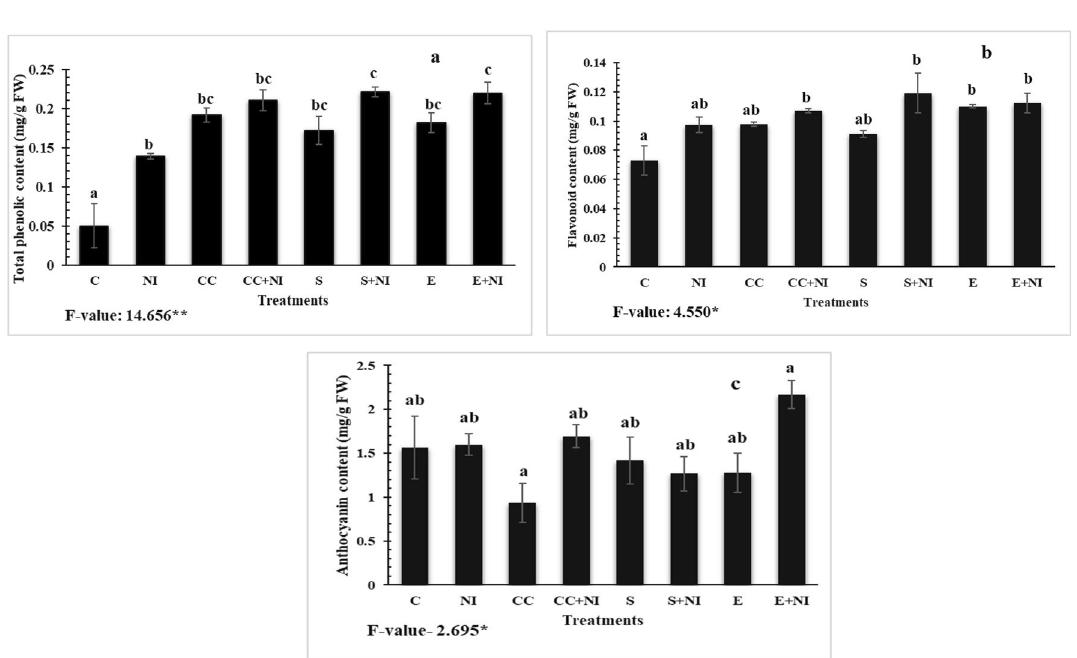
Figure 6. ( a-c ) Level of phenolic compounds ( a ) Total phenolic content; ( b ) Flavonoid content; ( c ) Anthocyanin content in M. incognita inoculated 60 days old tomato plants treated with S. hydrogenans strain DH-16. Different treatments are represented as C (control), NI (nematode inoculated), CC (culture cells), CC + NI (culture cells + nematode inoculated), S (supernatant), S + NI (supernatant + nematode inoculated), E (crude extract), E + NI (crude extract + nematode inoculated). Results are given in mean ± standard error and F-value *indicates significance at p ≤ 0.05 as per Tukey’s test. Different letters a, b represents significant difference among treatments and same letters represent no significant